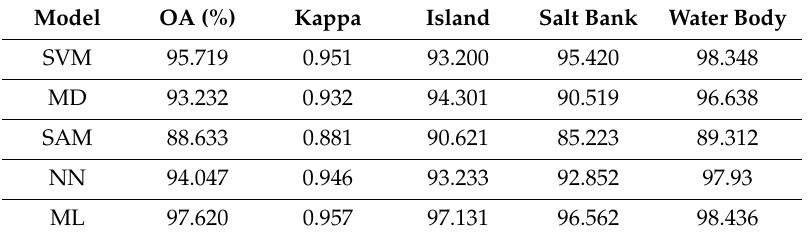
Table 3. Land area (km 2 ) by di ff erent supervised classification algorithms in 2010.